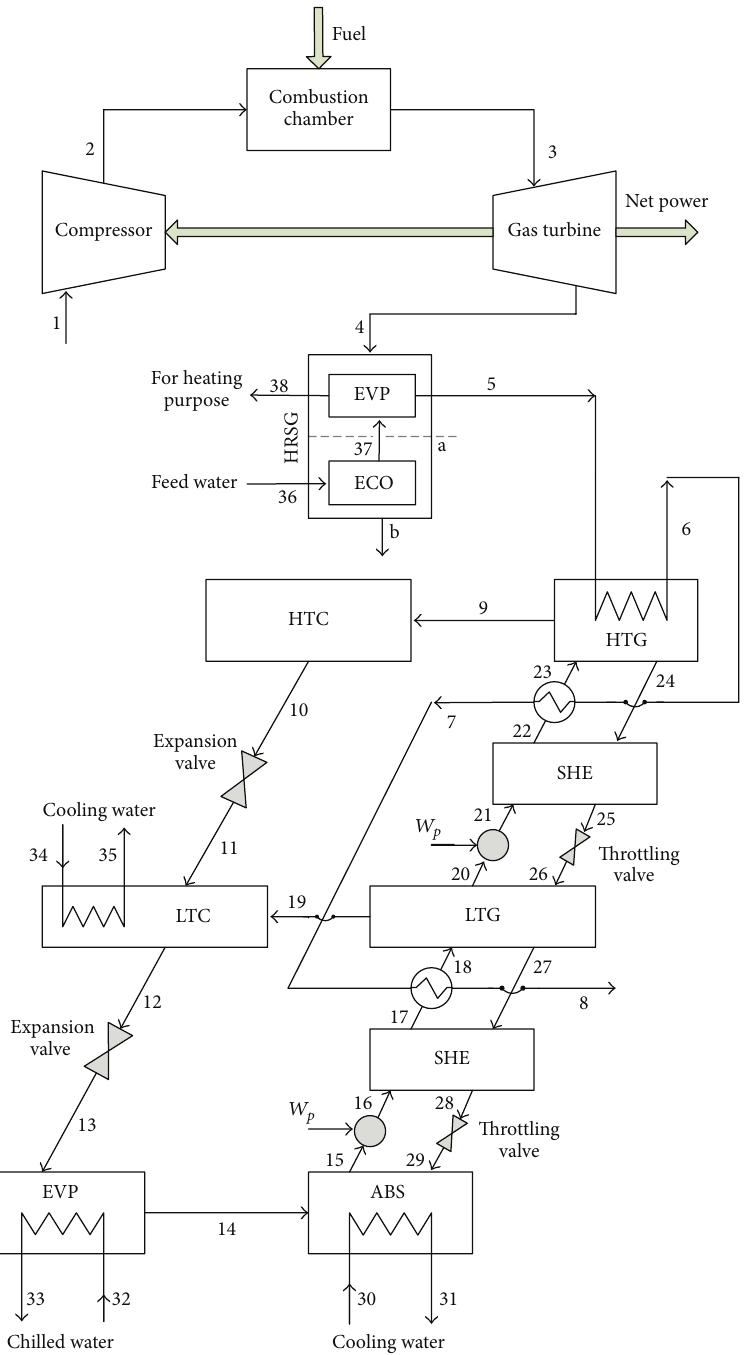
Figure 1: Schematic of the CCHP